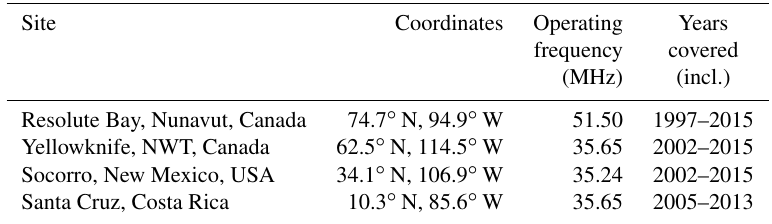
Table 1. List of radar sites, geographical coordinates, operating frequencies, and years of available